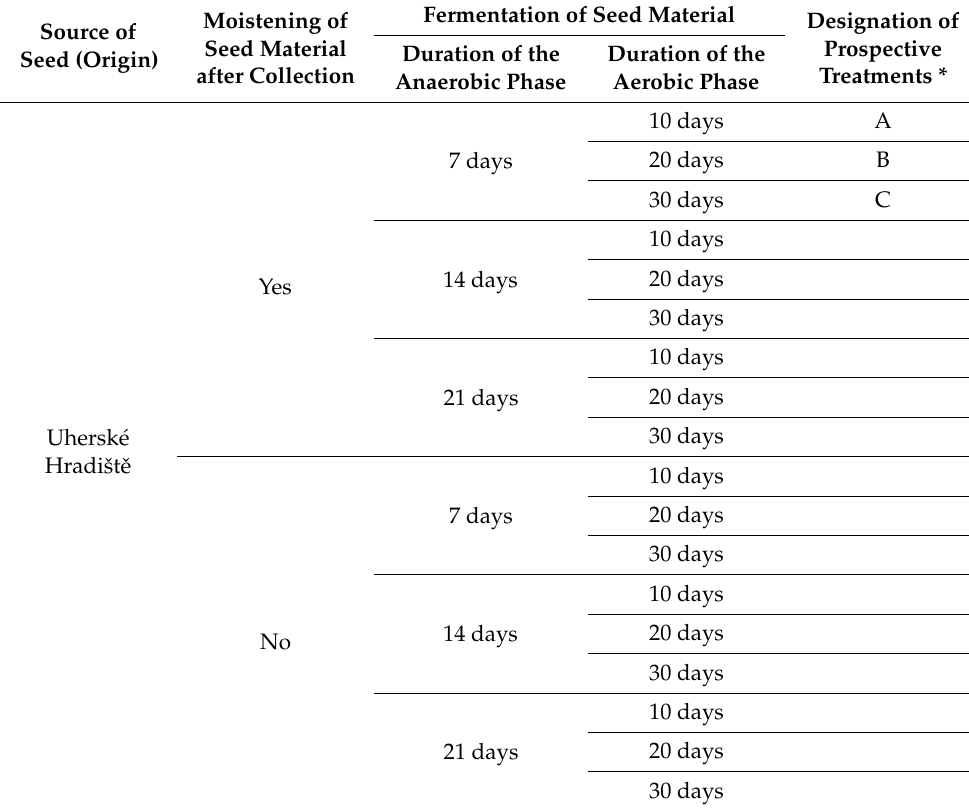
Table A1. An overview of tested pre-sowing